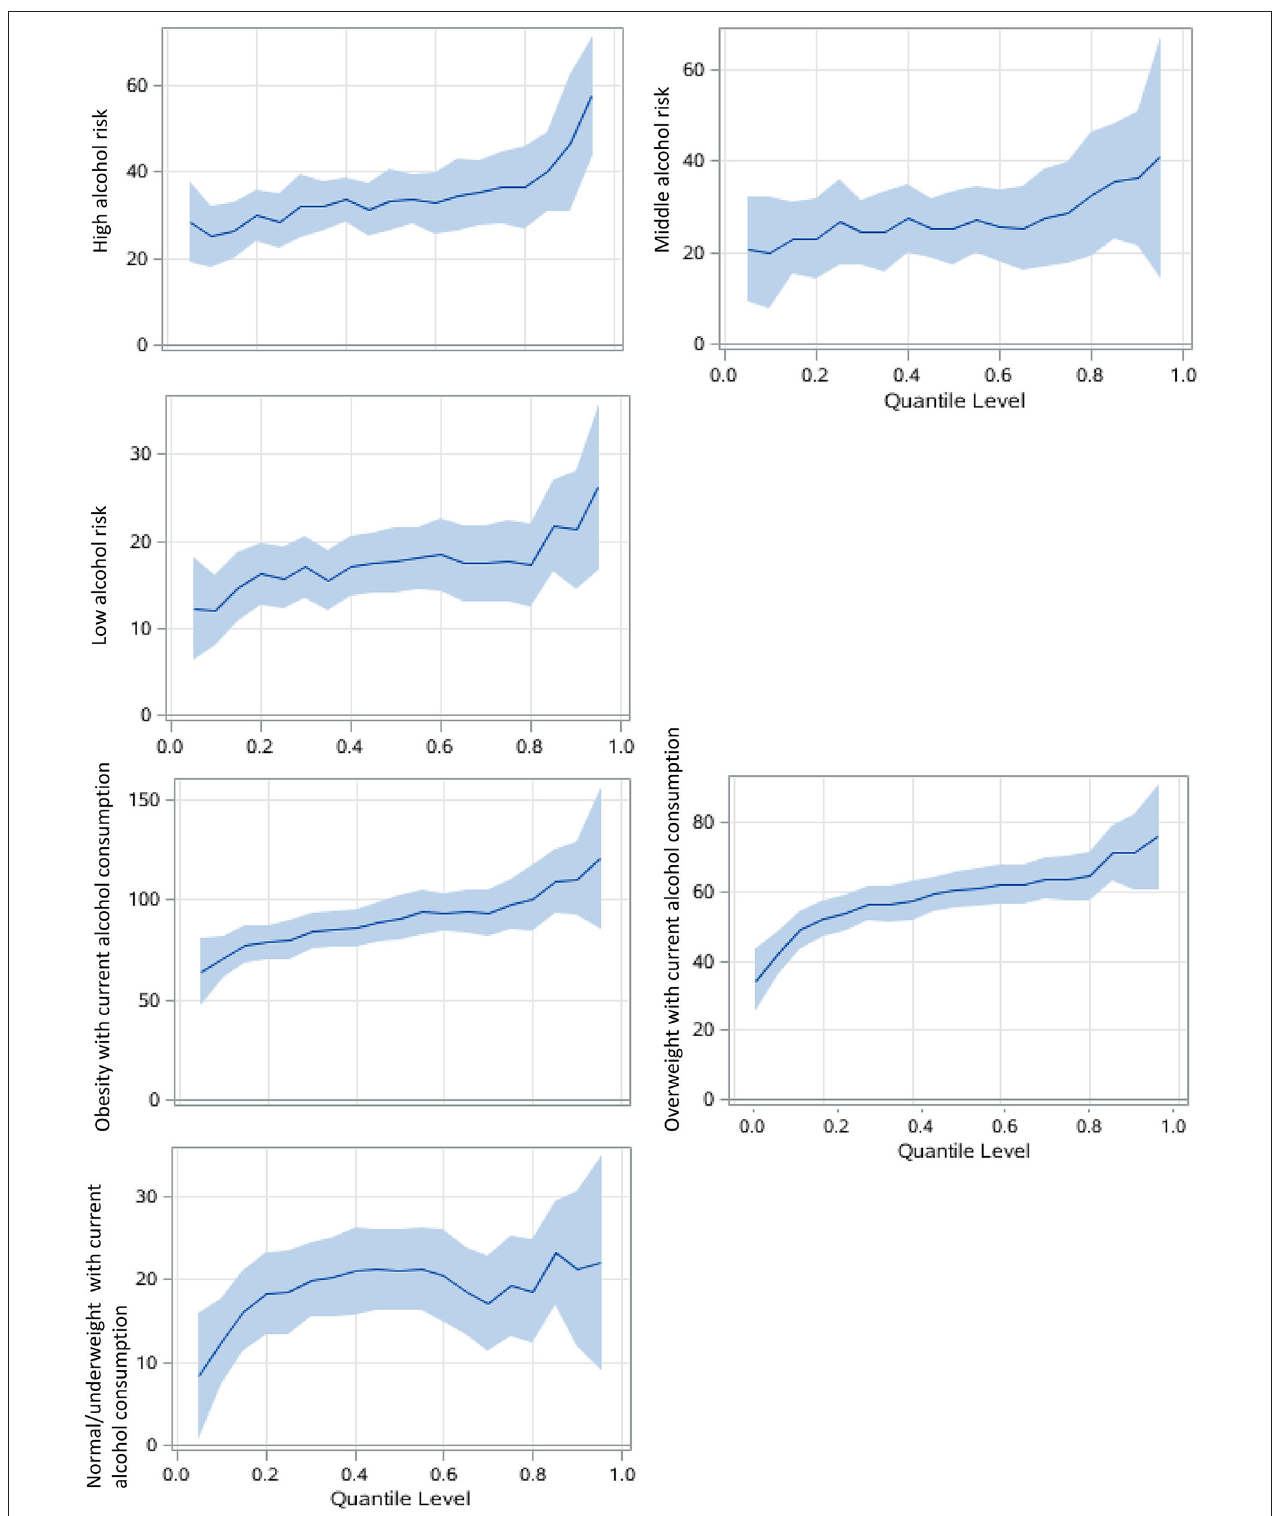
FIGURE 3 | Alcohol consumption associations with SUA among men using QRs. The never drink group was the reference group. The models focusing on alcohol risk levels are adjusted for age, study sites, residential areas, educational attainment, and body adiposity categories. The BMI-alcohol consumption combined models are adjusted for covariates similarly except for body adiposity. The x-axis is the quantile level of SUA, and the y-axis is the difference of SUA level between the current group and the reference group The solid lines represent the estimated effect of the associations, and the shadows are their 95% confidence intervals.